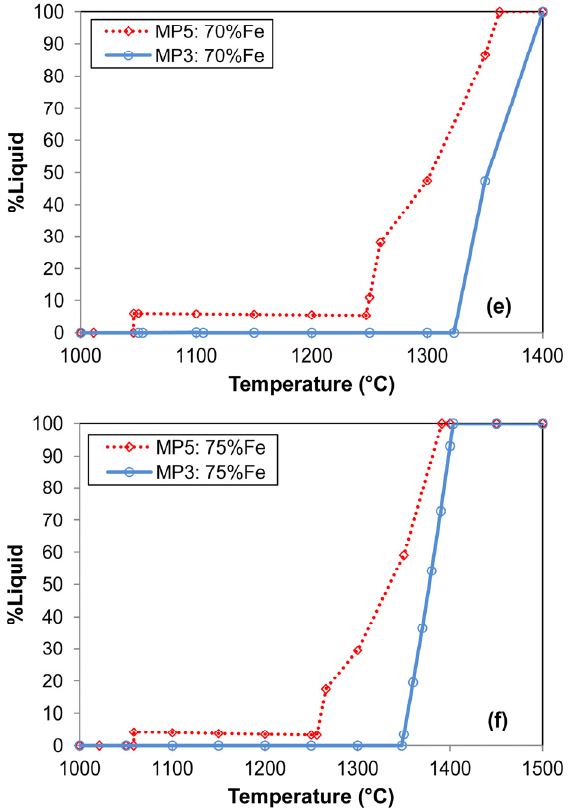
Figure 10. ( a – f ) Liquid alloy proportions in Cu-Al-Ti-Cr-Fe alloy at increased %Fe, as calculated in FactSage 7.3 [33].